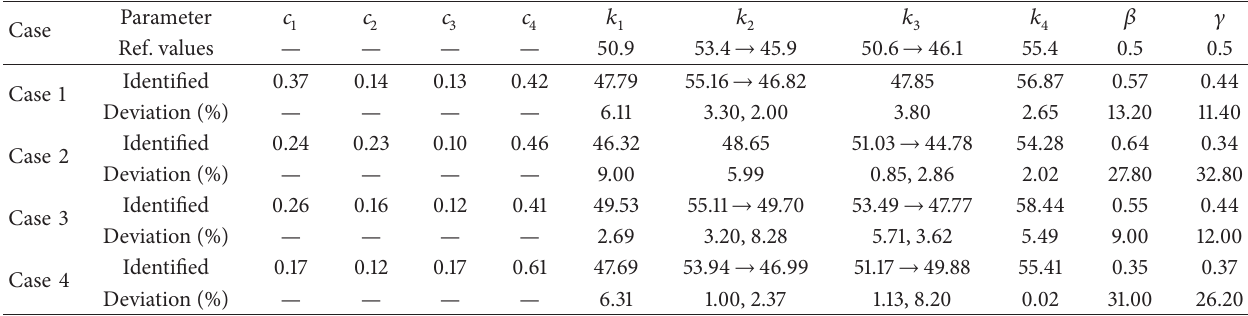
Table 1: Identified results for all